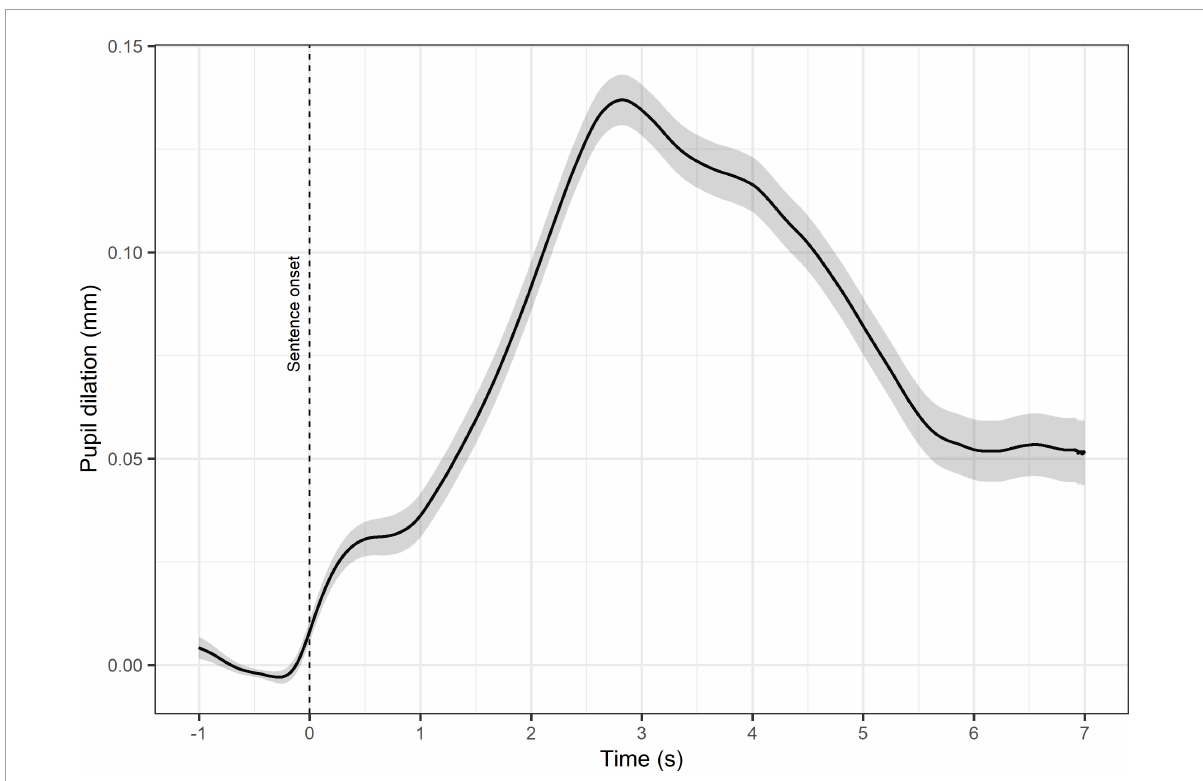
FIGURE1 Time course of the pupillary response averaged during a time interval ranging from the background noise 1 s prior to the sentence onset (dotted line) and up until the beginning of the background noise corresponding to the following sentence. The pupillary response prior to the sentence onset is defined as sentence baseline. The shaded area represents the confidence intervals at the 95% level.